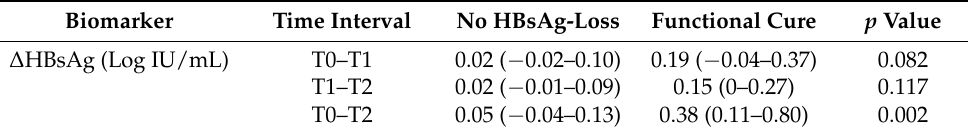
Figure 2. Comparison of HBsAg decline from baseline to T1 ( A ), from T1 to T2 ( B ) and from baseline to T2 ( C ) in patients achieving a functional cure and those with no HBsAg loss. Hollow circles indicate values that are larger than the upper quartile plus 1.5 times the interquartile range while red squares indicate values that are larger than the upper quartile plus 3 times the interquartile range. Abbreviations–HBsAg decline ( Δ HBsAg), hepatitis B surface antigen (HBsAg). Table 3. Comparison of the magnitude of HBsAg decline between patients achieving a functional cure and those with no HBsAg loss.